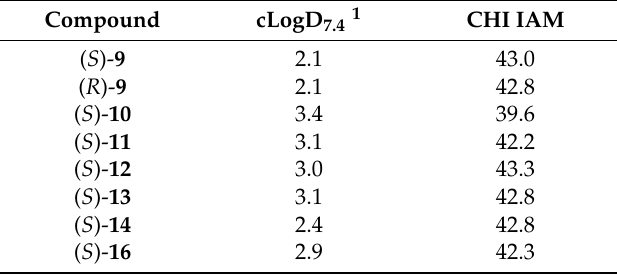
Table 3. Calculated logD 7.4 values and experimentally determined CHI IAM